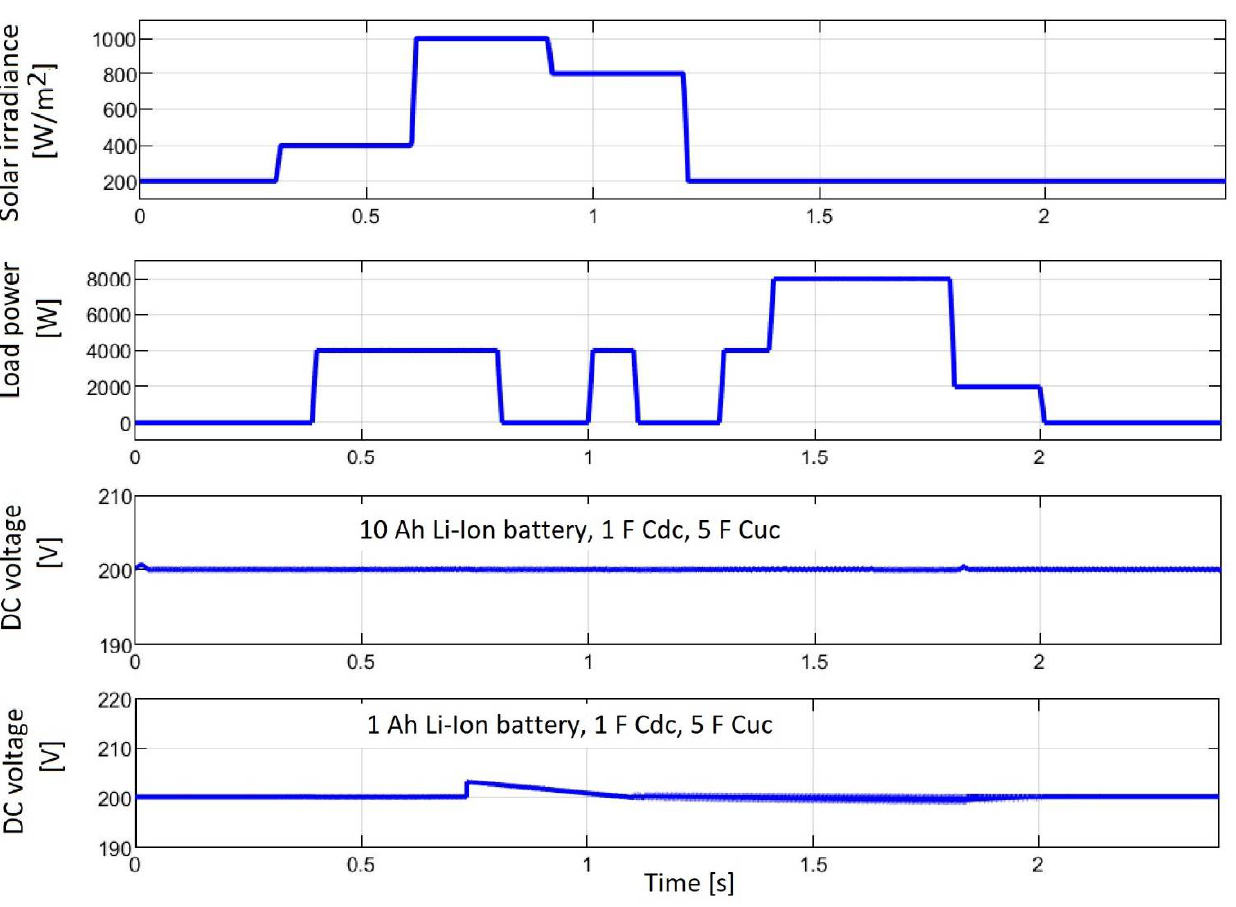
Figure 17. The DC voltage variation of the PV/FC/ESS system using strategy S2 in the scenario SC7.